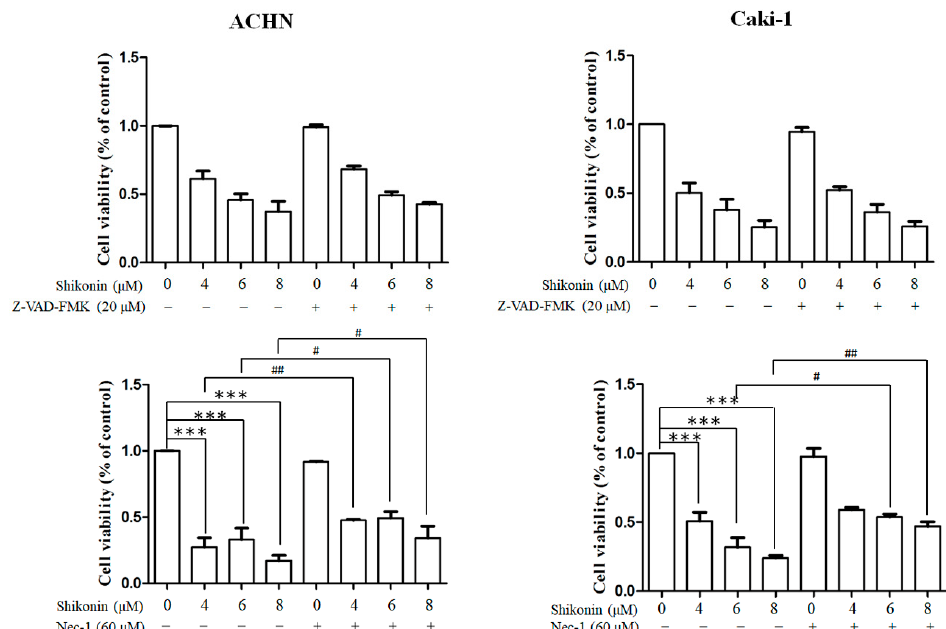
Figure 3. Necrostatin-1 but not Z-VAD-FMK reversed shikonin-induced cell death. ACHN ( left panel ) and Caki-1 ( right panel ) were treated with shikonin with or without Z-VAD-FMK ( upper panel ) or necrostatin-1 (Nec-1; lower panel ). Data represent means ± standard deviation from at least three independent experiences. *** p < 0.001 compared with the control group. # p < 0.05 and ## p < 0.01 compared with the Nec-1 pretreated group.